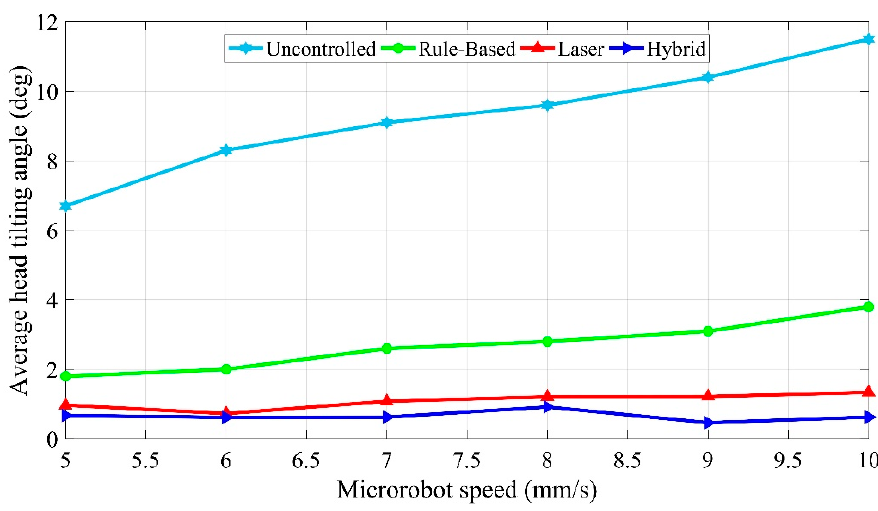
Figure 20. Comparison of average head-tilting angles in the speed range of 5–10 mm/s.